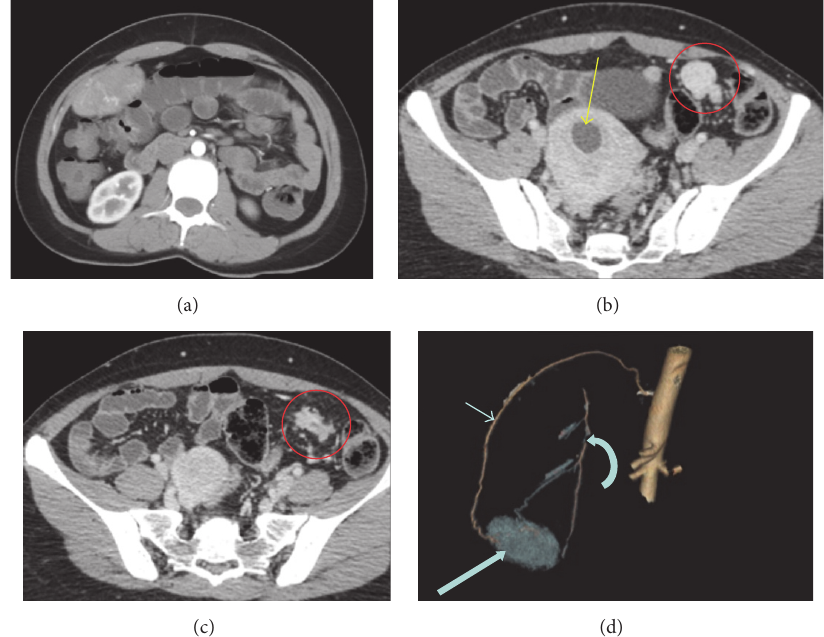
Figure 1: CT angiography. Axial section through right hypochondrium showed a well-defined oval shaped enhancing mass lesion along the peritoneal surface (a); axial section through the lower abdomen revealed few round well-defined homogenously enhancing soft tissue lesions in the mesentery (red circle in (b) and (c)) and yellow arrow shows a postsurgical changes in the uterus (b); volume rendering image of the right hypochondrium (d) shows the blood supply from right 10th intercoastal artery (thin arrow) and from the branch of right internal mammary artery (curved arrow). Thick arrow represents the mass